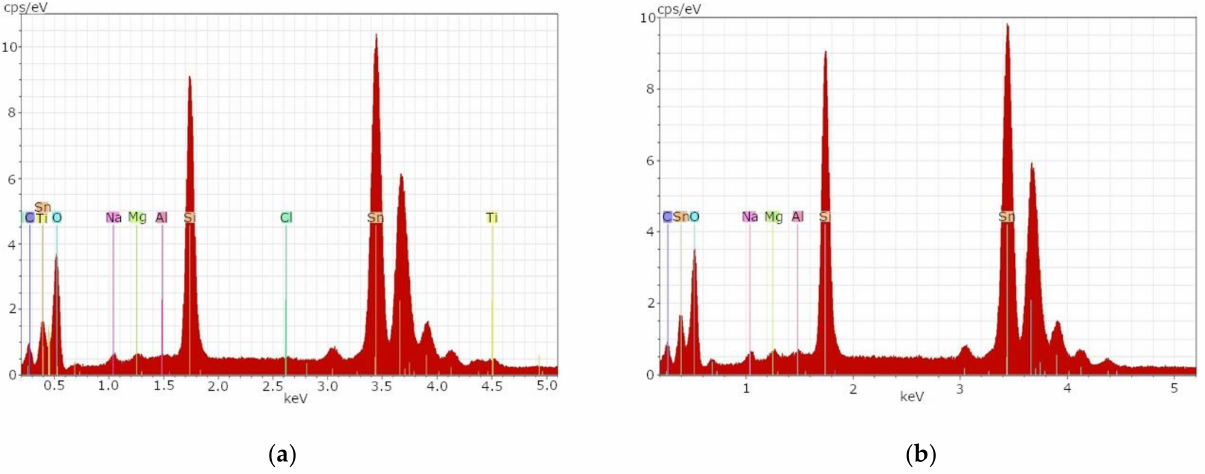
Figure 2. SEM-EDX result for sample t1B, the FTO-coated back electrode of a DSSC: ( a ) before etching; ( b ) after etching with hydrofluoric acid 1